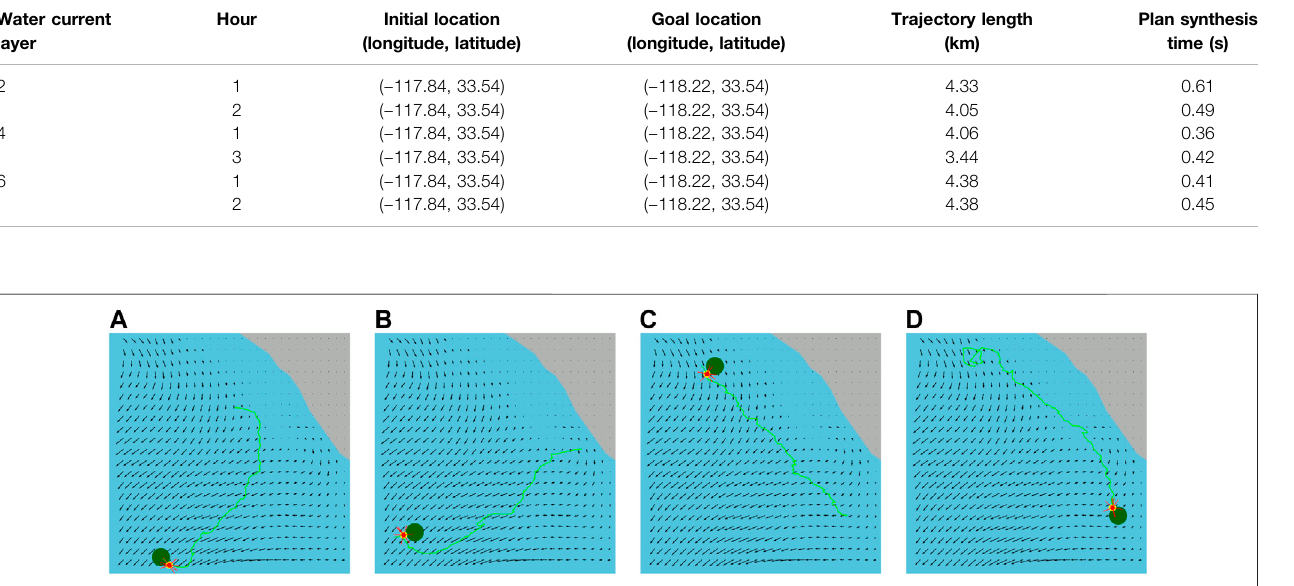
Goal location (longitude, latitude)